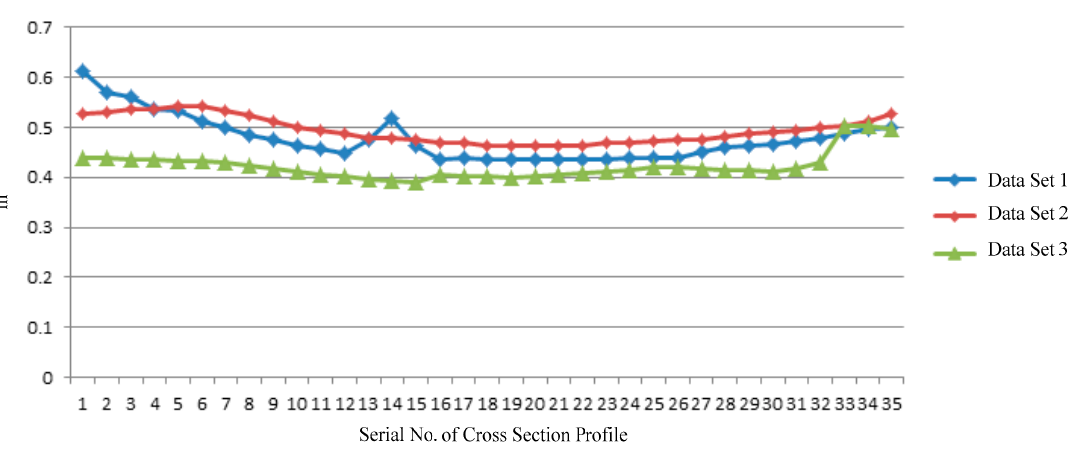
Figure 18. Clearance distance between OCL and the top of clearance test frame.